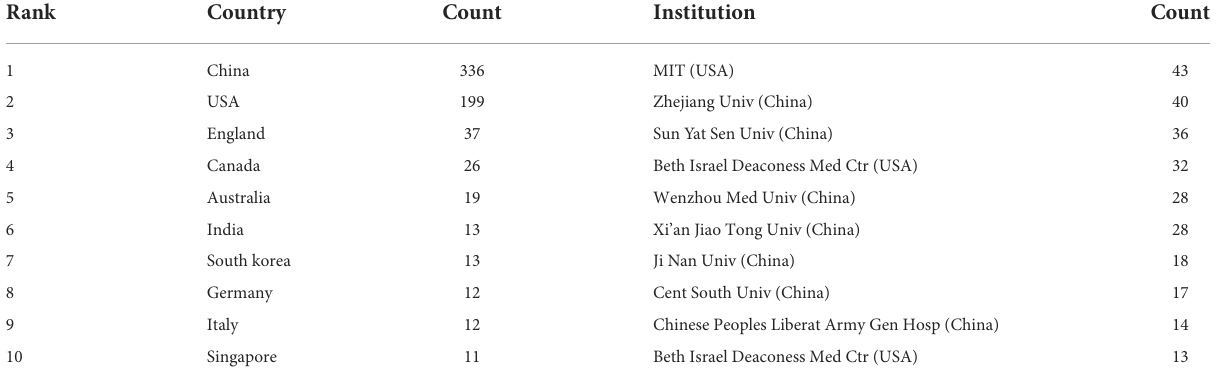
TABLE 2 Top 10 countries and institutions in terms of the publication number.